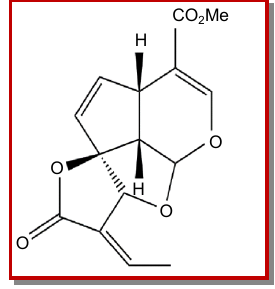
Figure 1. Chemical structure of